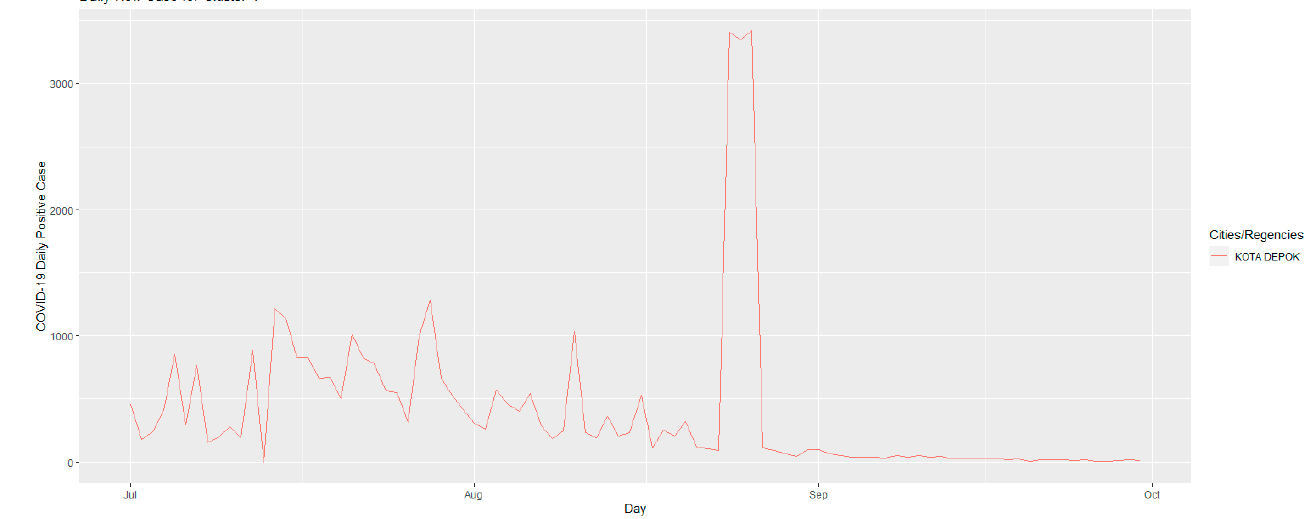
Figure 7. Daily positive cases of COVID-19 in Cluster 4 for the first period.